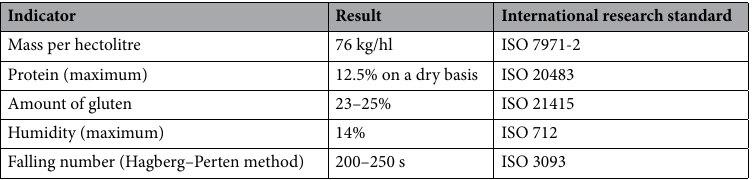
Table 1. Indicators of the quality of class 3 wheat grain.